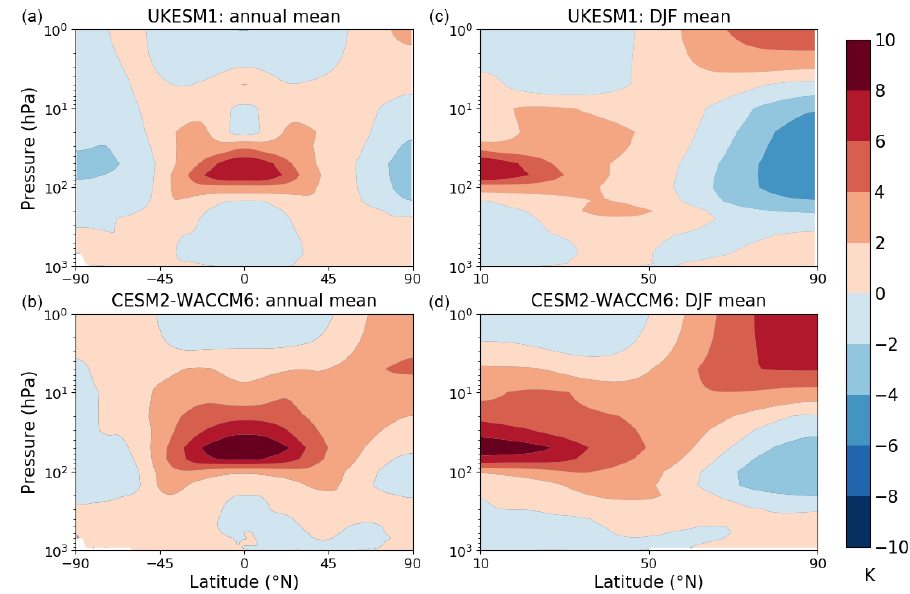
Figure 4. The difference in zonal mean temperature (K) diagnosed from { G6sulfur minus G6solar } ; panels (a) and (c) show results from UKESM1 and panels (b) and (d) from CESM2-WACCM6. Panels (a) and (b) show global annual-mean results from 2081–2100; panels (c) and (d) show Northern Hemisphere winter (December–February) means over the same